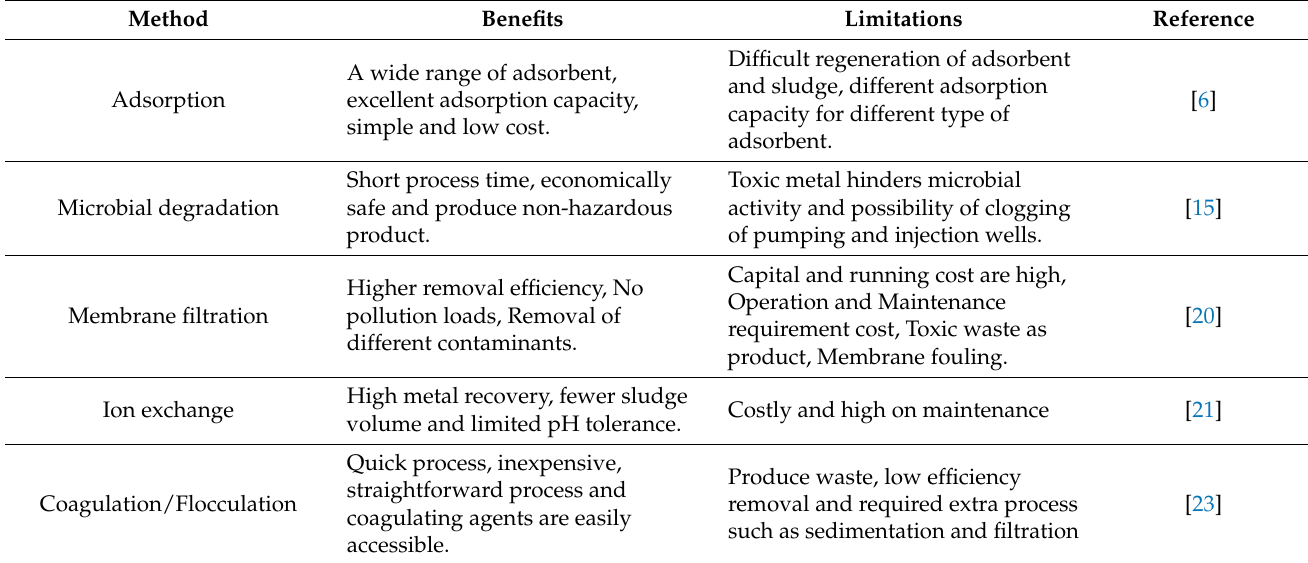
Table 4. Summary of conventional wastewater treatment processes. Adopted from reference [22] (copyright reserved Elsevier, 2019).